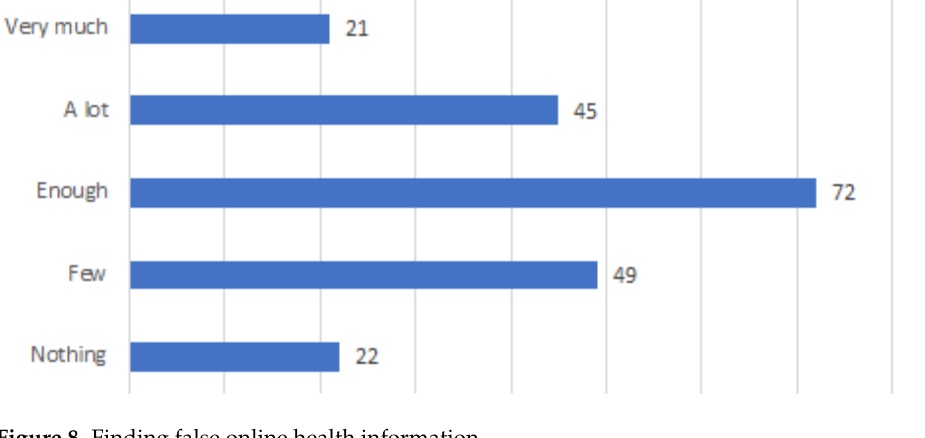
Figure 8. Finding false online health information.